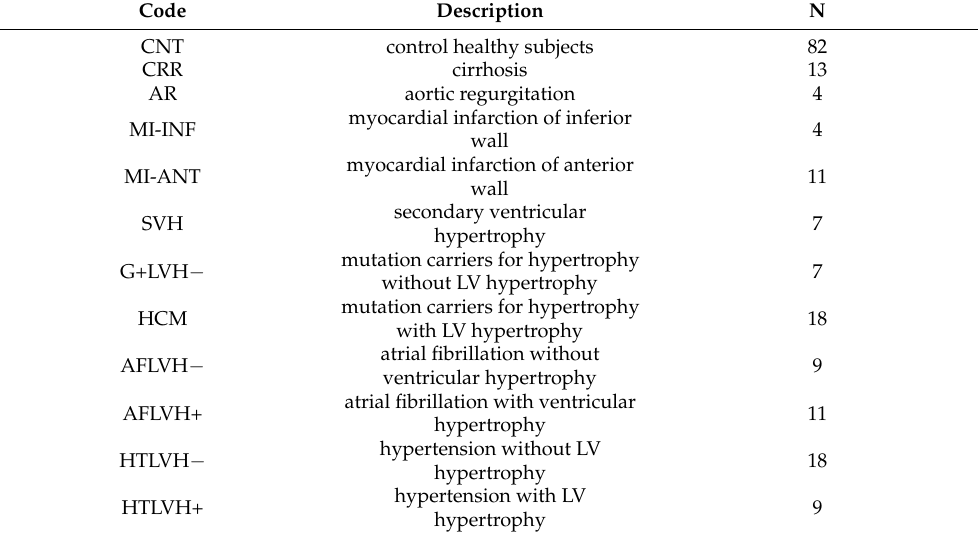
Table 1. Subjects categories.